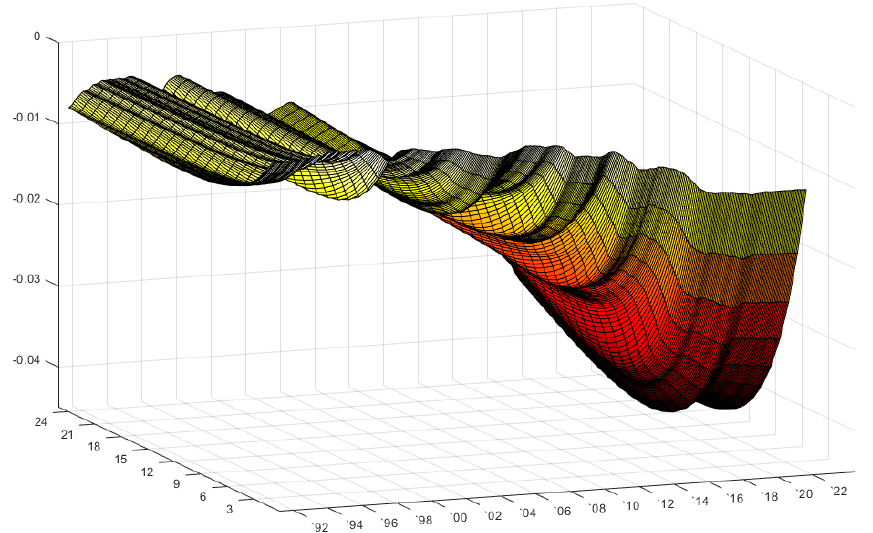
Figure 6. Time-varying impulse response to housing prices (based on Korea Real Estate Board Price Index). Note: X-axis: time of impulse response; Y-axis: magnitude of impulse response; and Z-axis: duration of impulse response. Source: estimated by the authors with the TVP-VAR model.